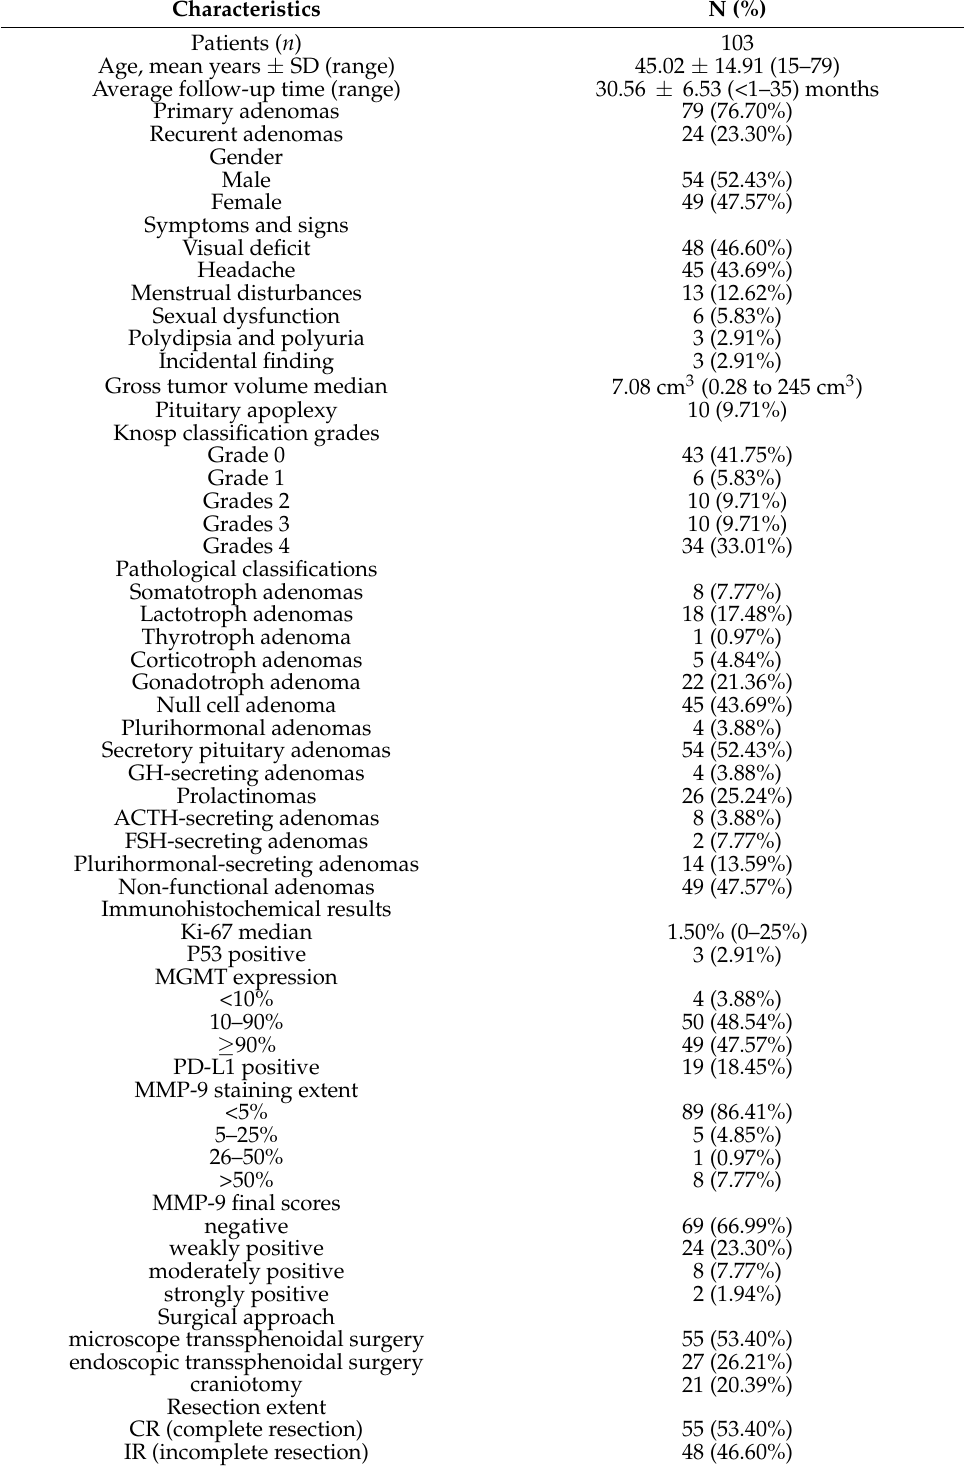
Table 1. Characteristic clinical features of the patients with pituitary